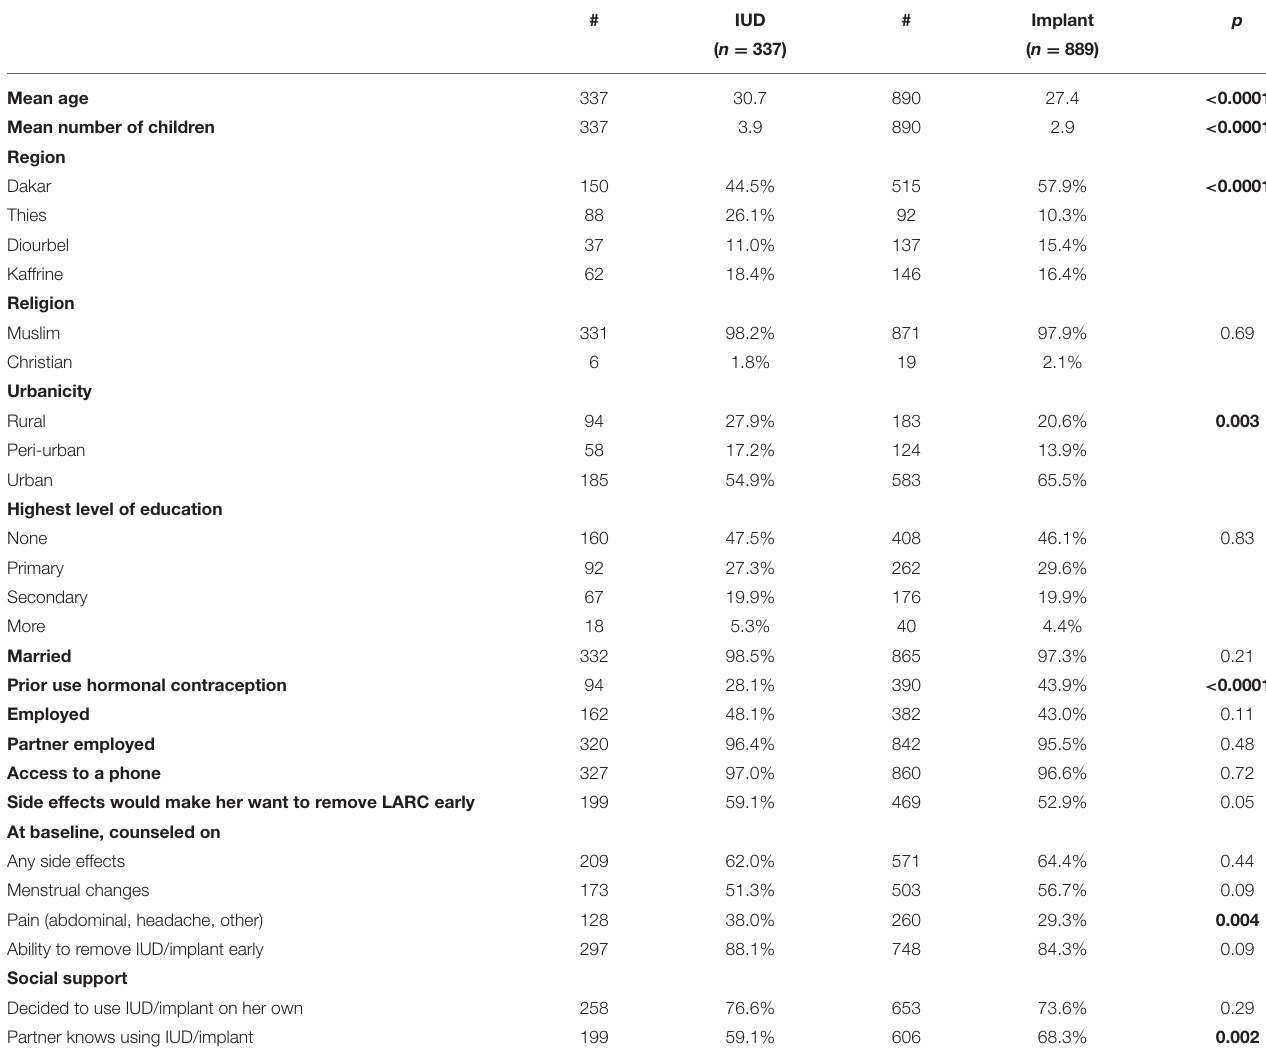
TABLE 5 | Bivariate associations between variables of interest and method accepted at baseline. # IUD